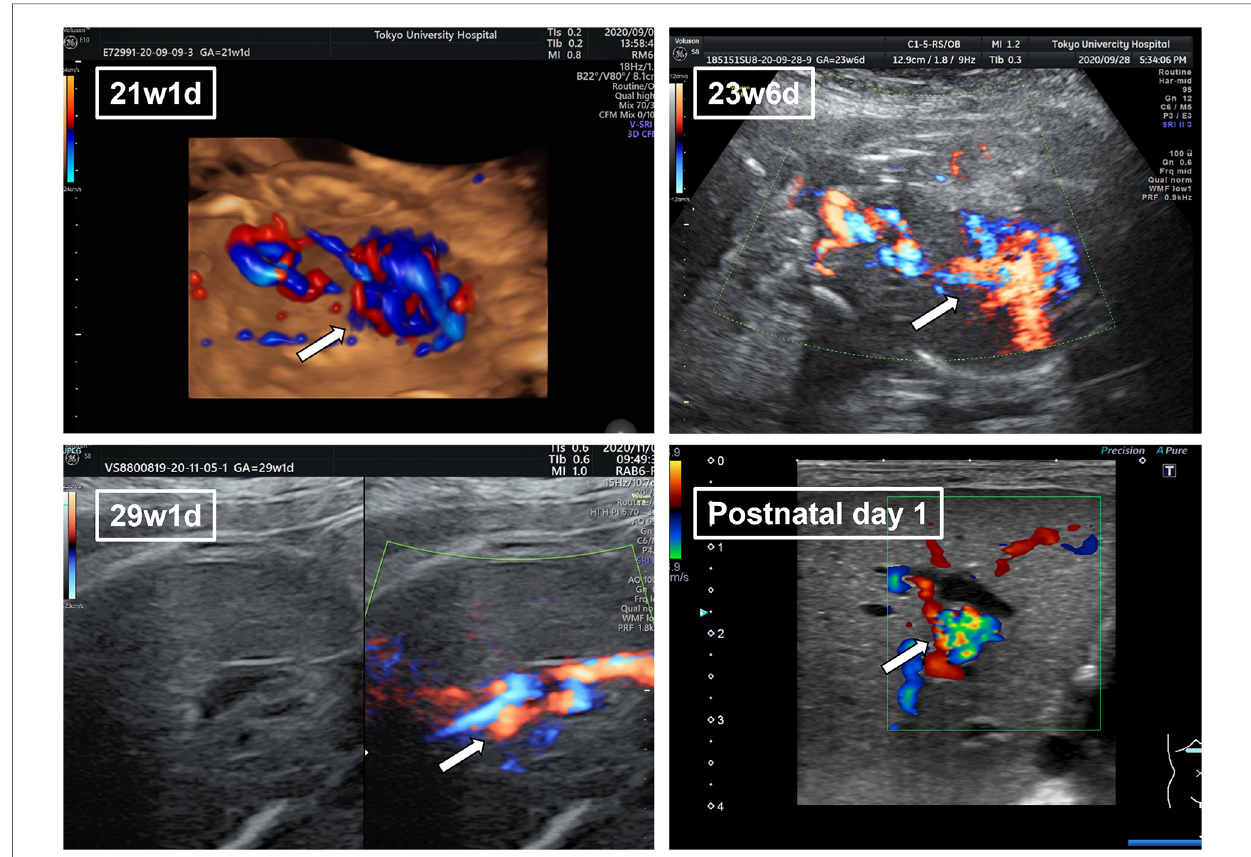
FIGURE 1 The fetal ultrasonography of umbilical vein varix (UVV) in the perinatal period. Fetal ultrasonography revealed a 17 mm×10 mm UVV near the hepatic hilum (arrow). Dilation of the umbilical vein remained the same throughout the perinatal